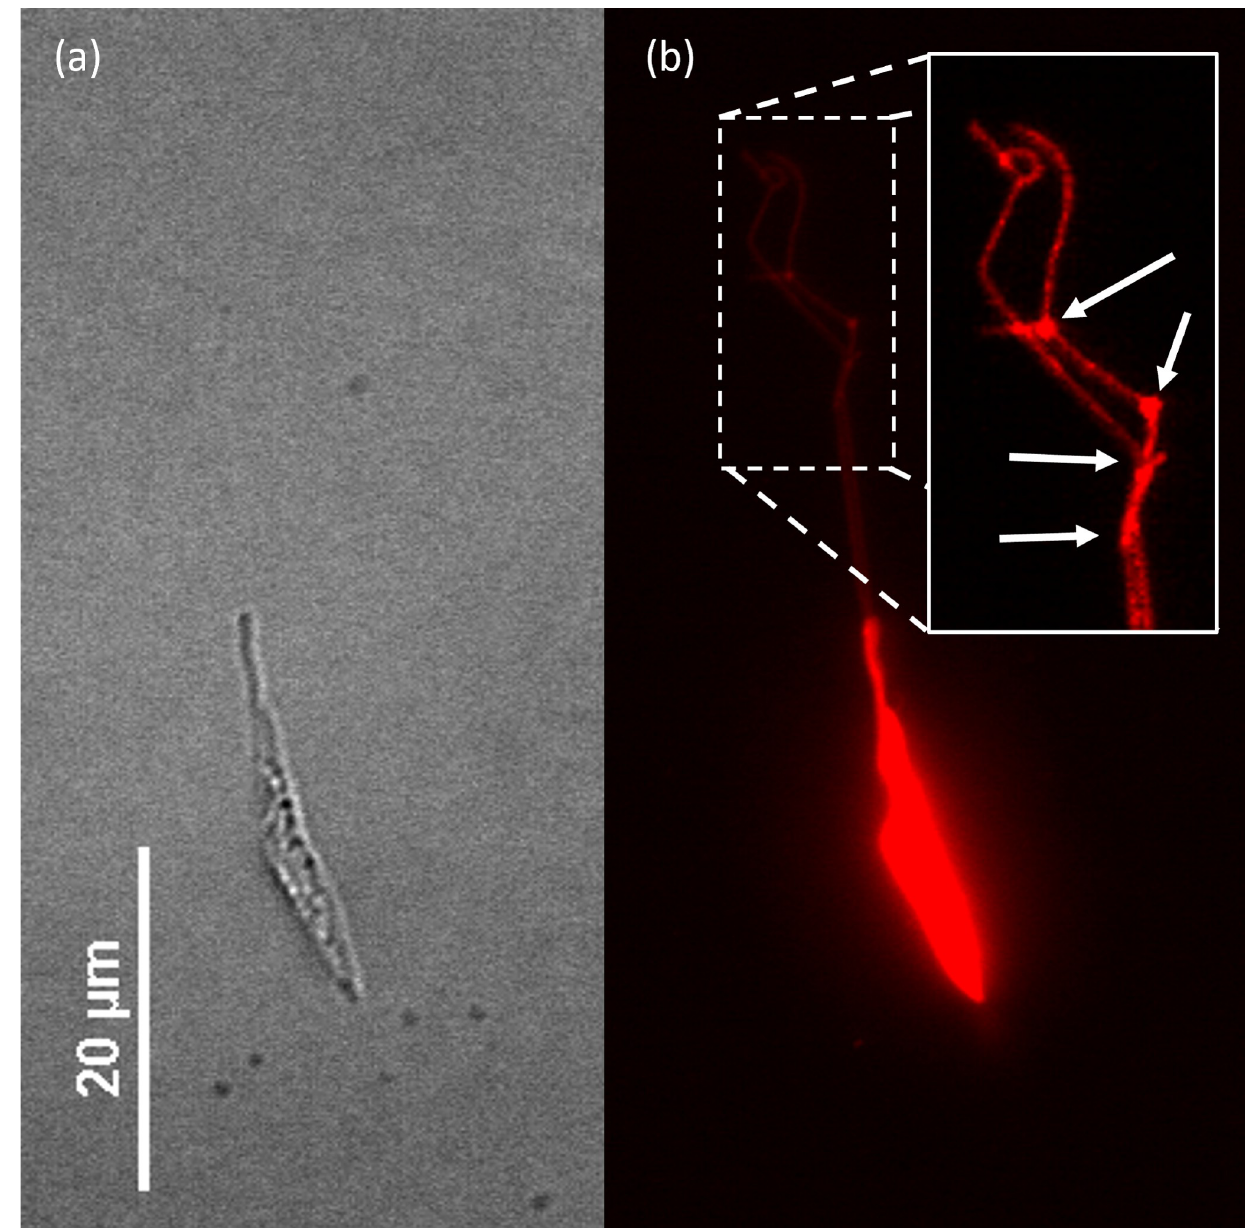
Fig 4. Secondary adhesion points. Epimastigote dyed with R18 and subjected to 1.55 pN/ μ m 2 of shear stress; in bright field microscopy at 40X (a) the adhesion structures are not visible, but in fluorescence (b) two nanotubules by which the parasite is attached are visible, as well as secondary anchoring pads (inset: Adjusted brightness, G = 2.89) marked by white